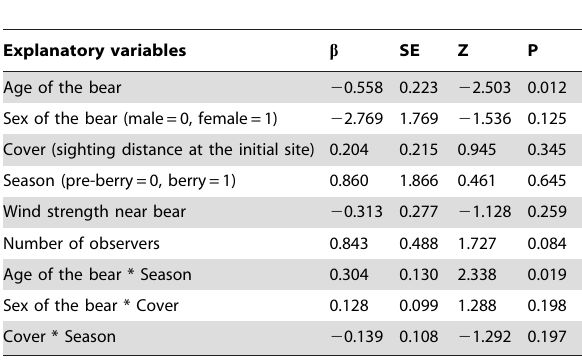
Table 1. Results from the generalised linear mixed model for remaining or leaving the initial site.